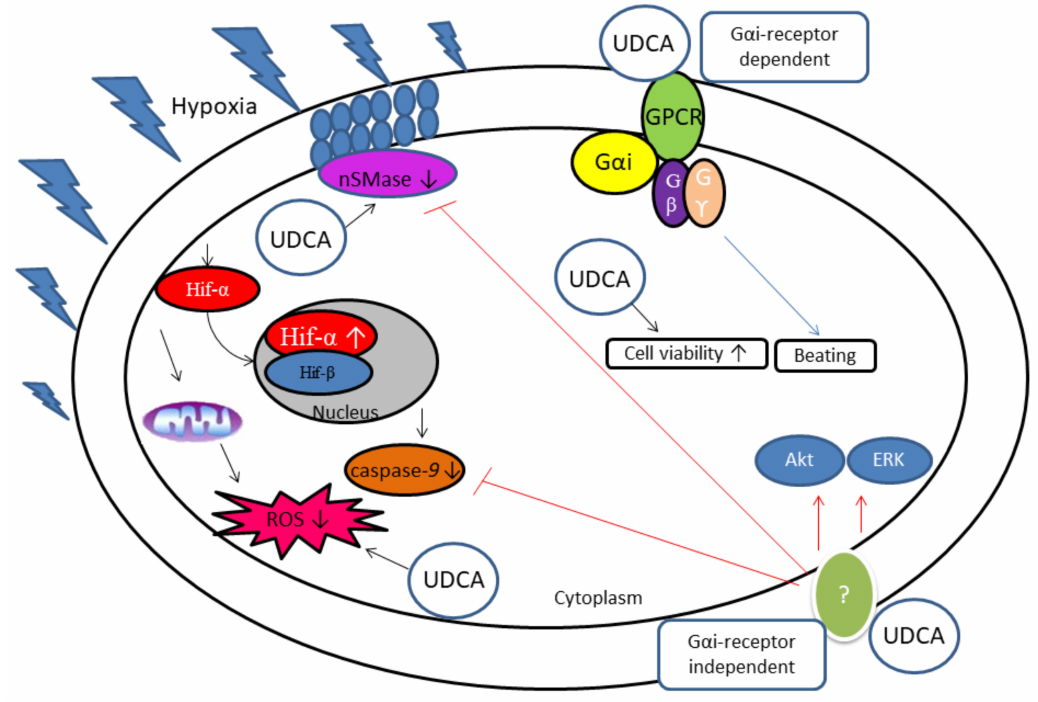
Figure 2. Proposed anti-apoptosis mechanism for UDCA cardioprotection against hypoxia. Pertussis toxin does not block the effect of UDCA on caspase-9, neutral SMase expression, ROS production, and Hif-1 α expression in hypoxia-induced CMs. Beating rate is partially inhibited by